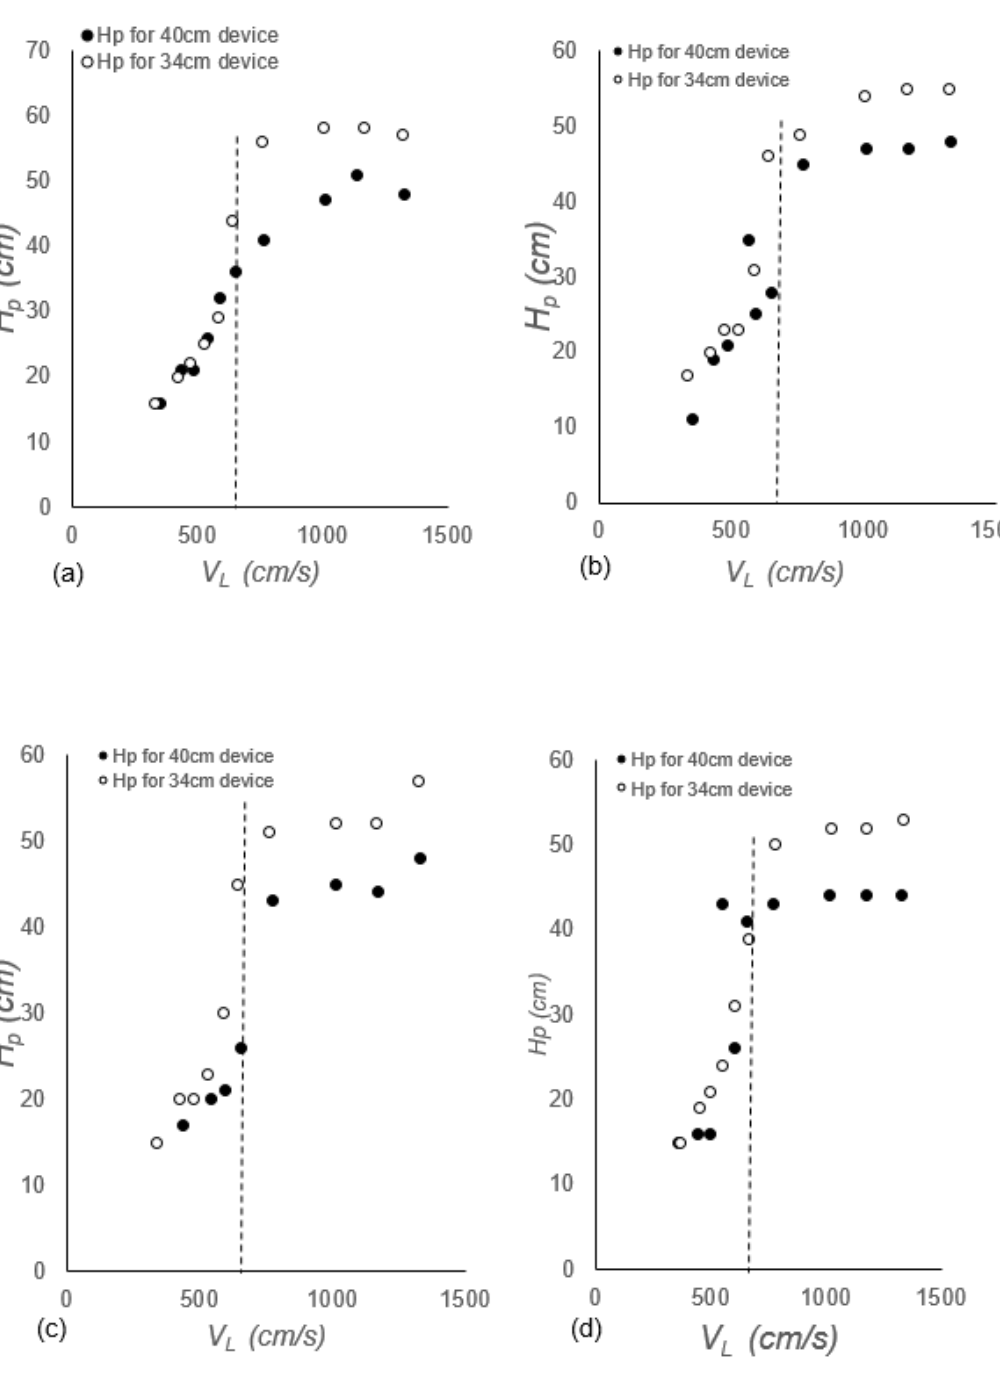
Figure 13. Effect of Hp for varying V L for different smart devices of length 40 and 34 cm at ( a ) d s = 0 ( b ) d s = 1, ( c ) d s = 3, ( d ) d s =